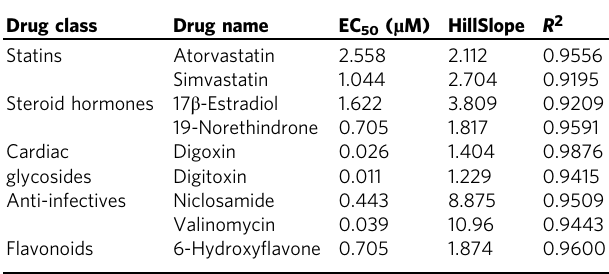
Table 1 Summary of drug classes found to inhibit RSV infection.